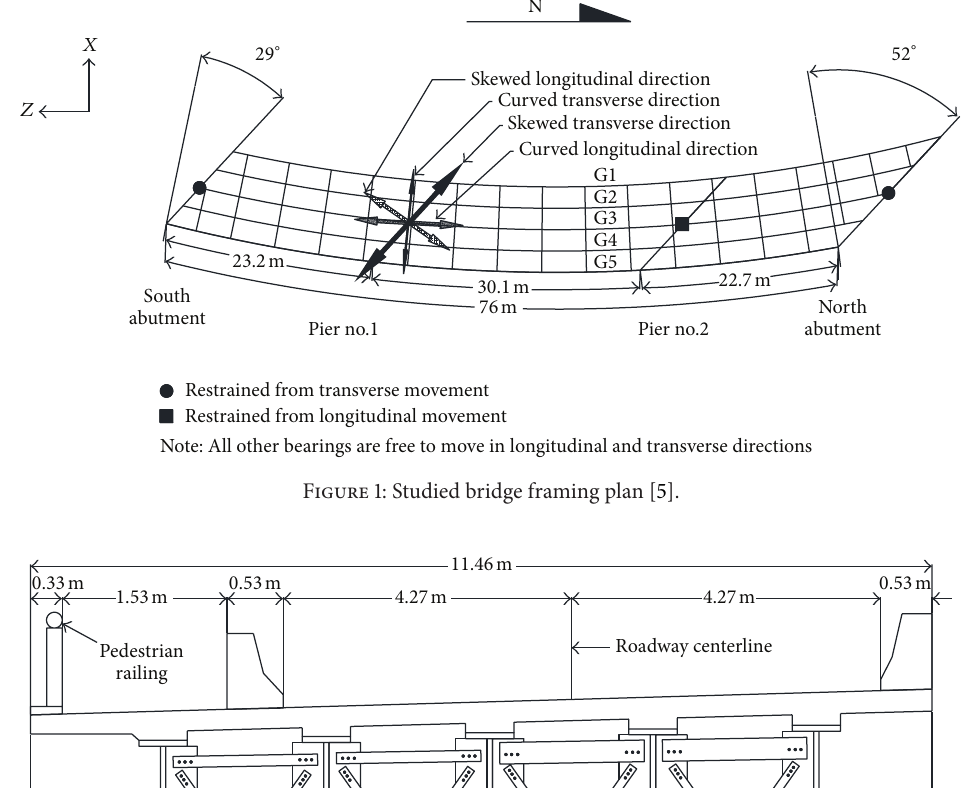
Figure 2: Typical bridge